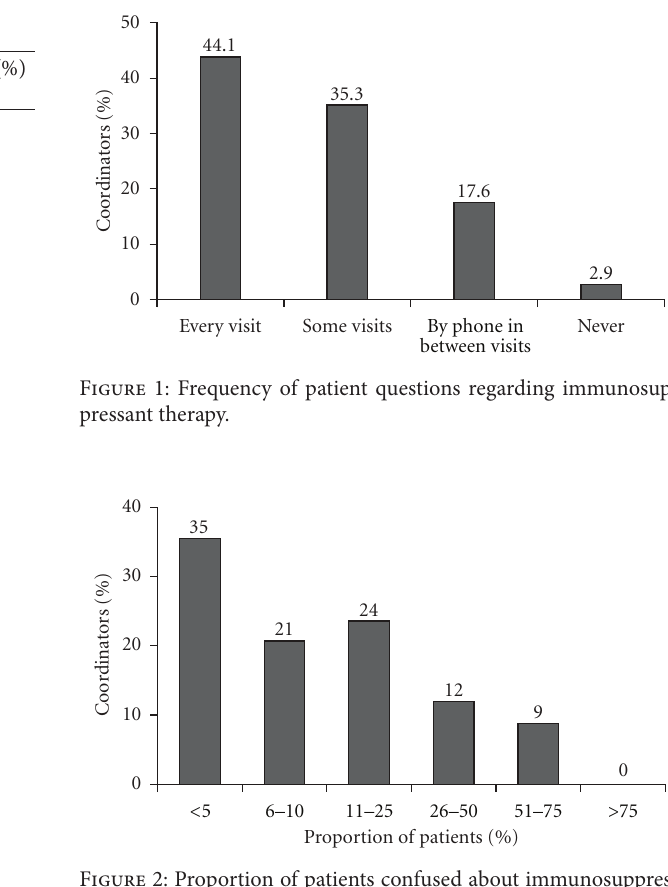
F 2: Proportion of patients confused about immunosuppres- sant